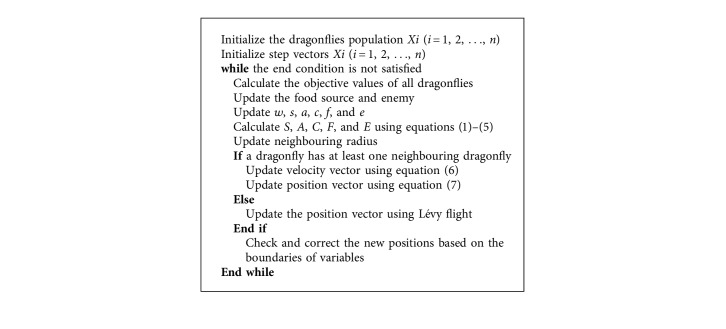
Pseudocode for DA [9].